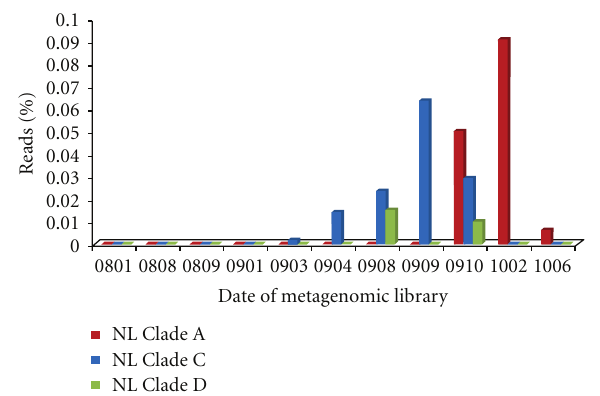
Figure 3: The temporal dynamics of c92-like protein clades in viral metagenomic data sets from a Nymph Lake (NL10) hot